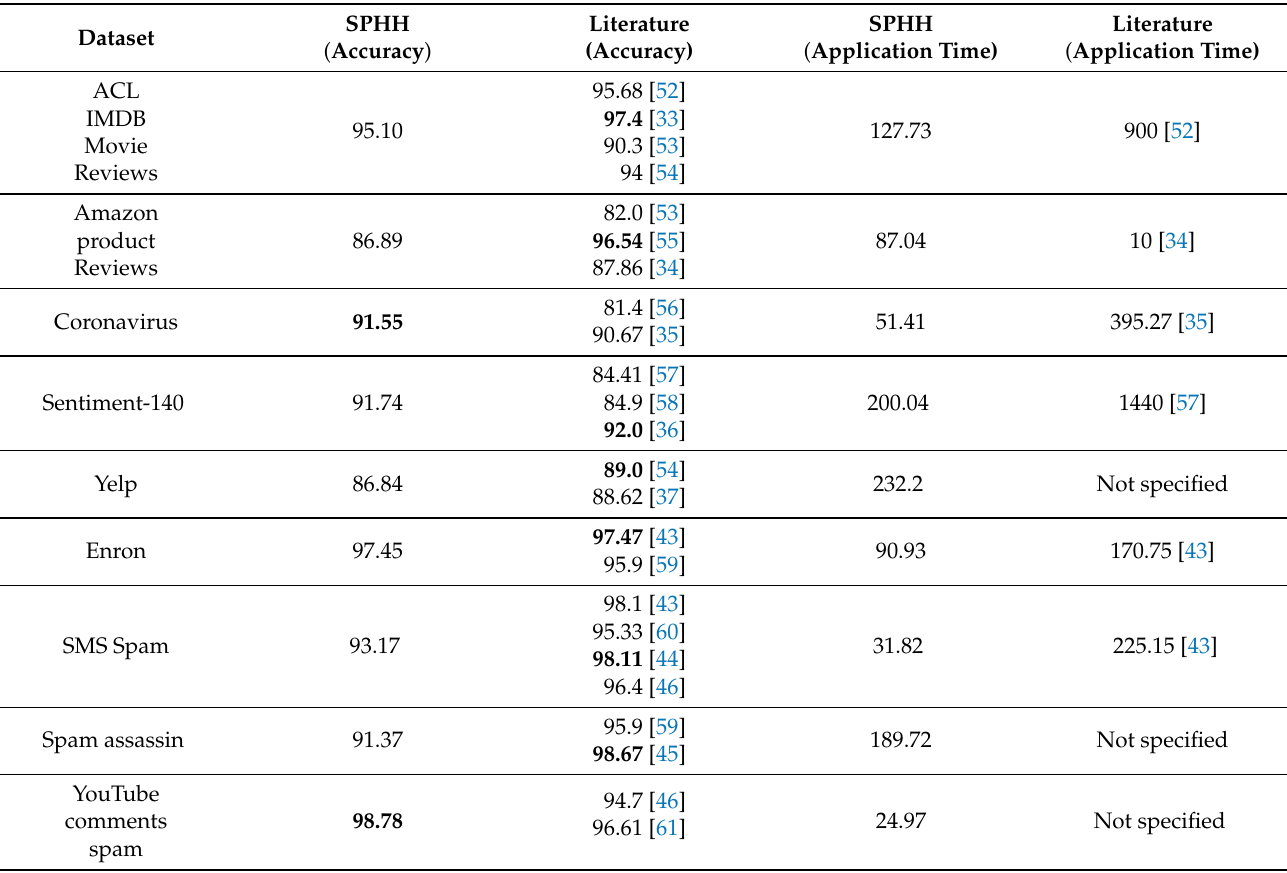
Table 6. Performance of SPHH compared with the state of the art and other deep neural network pipeline techniques for the text-processing datasets.